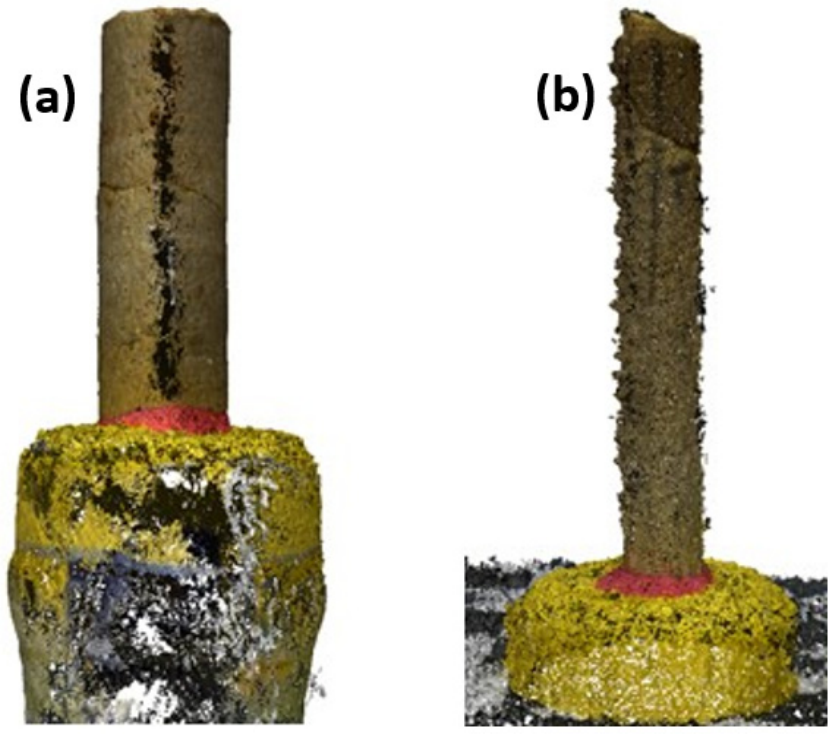
Figure 5. Reconstruction of two “Plug” samples. Image ( a ) presents flaws in the reconstruction of the side of the sample, showing a band without information. Image ( b ) presents problems in the reconstruction of the surface, which should be regular.